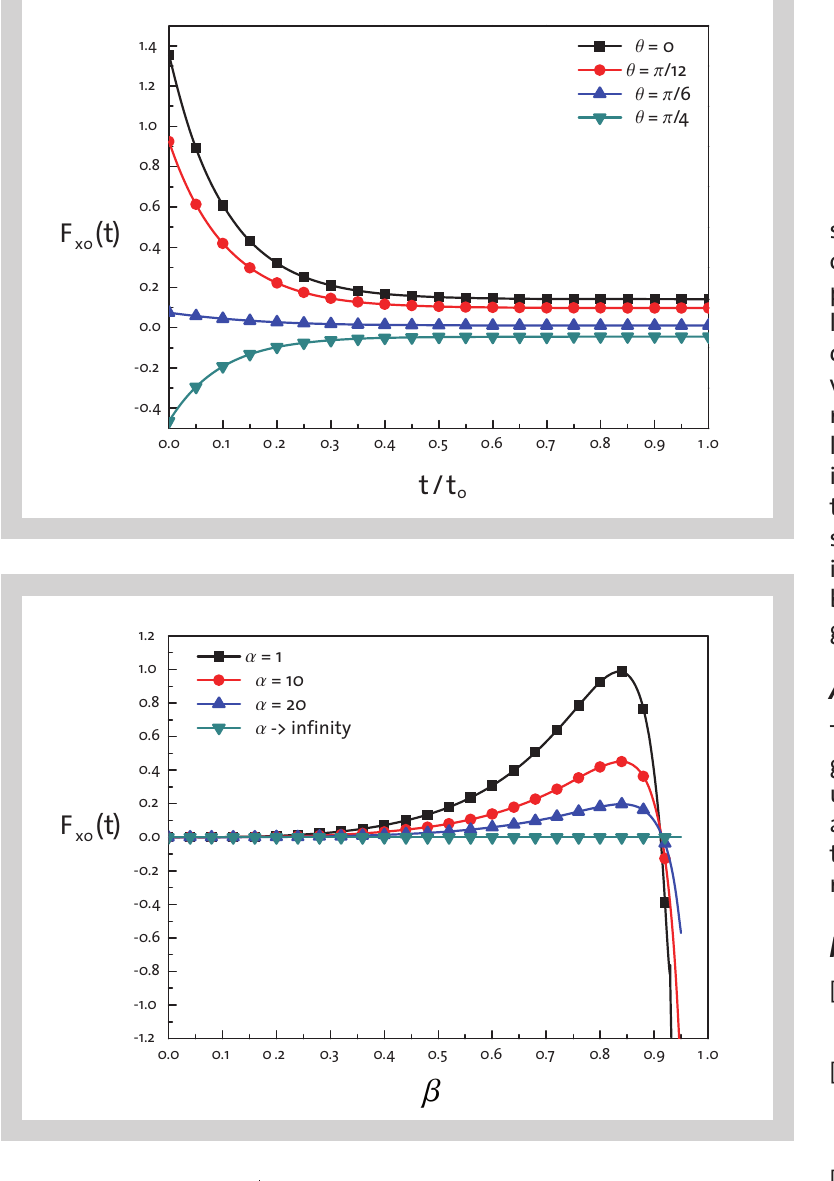
Figure 7: Normalized force F (t) x0 versus t/t with different q o for a = 10, x = 10, b = 0.8, and l = 1. Figure 8: Normalized force F (t) x0 versus b with different a for t/t = 0.1, x = 10, l = 1, and o q = p